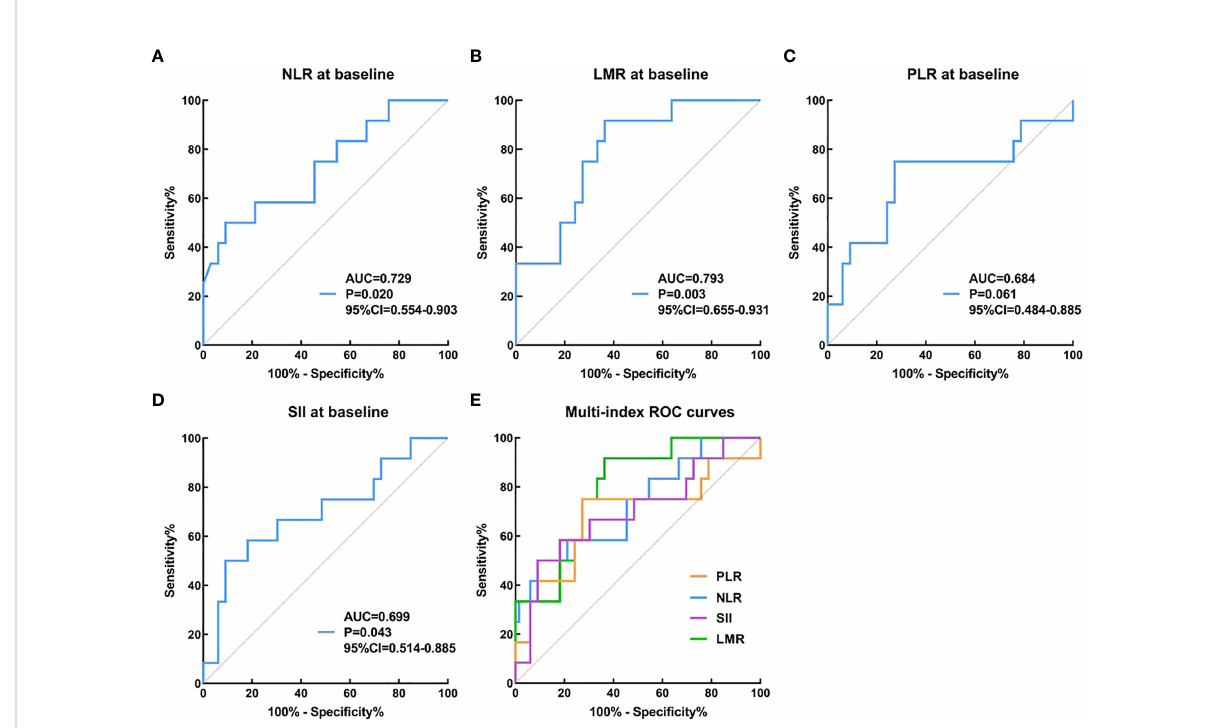
FIGURE 5 The prediction ability of serum in fl ammation indexes to distinguish pathological ef fi cacy. (A – E) : the therapeutic ef fi cacy was categorized into pathological tumor regression grades 0, 1, and 2 (response) and grade 3 (no response or poor